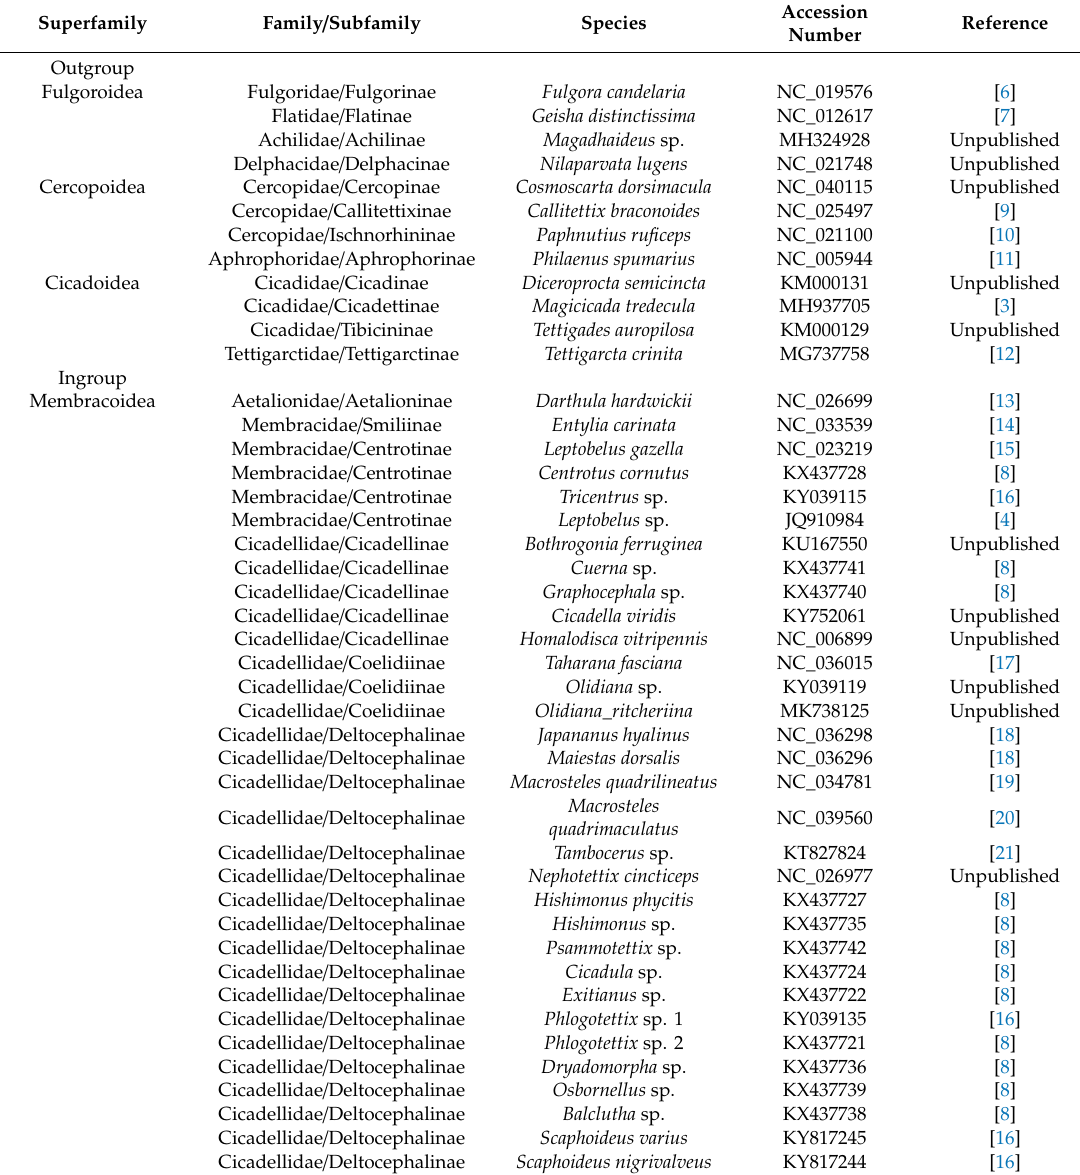
Table 1. GenBank accession numbers of mtgenomes for species sampled in this